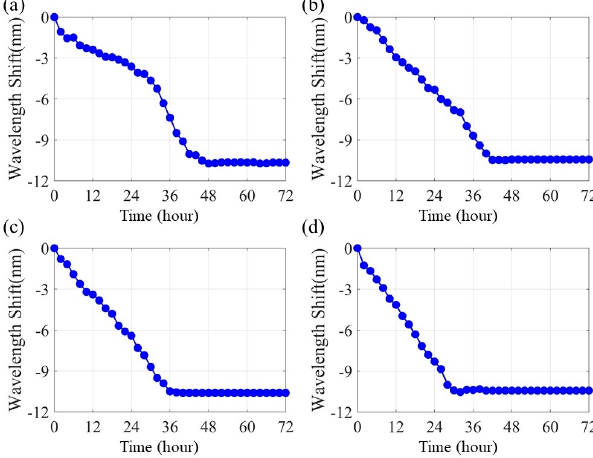
Figure 9. LPFG transmission spectra under various strains: ( a ) 0, ( b ) 500, ( c ) 1000 and ( d ) 1500 µε.